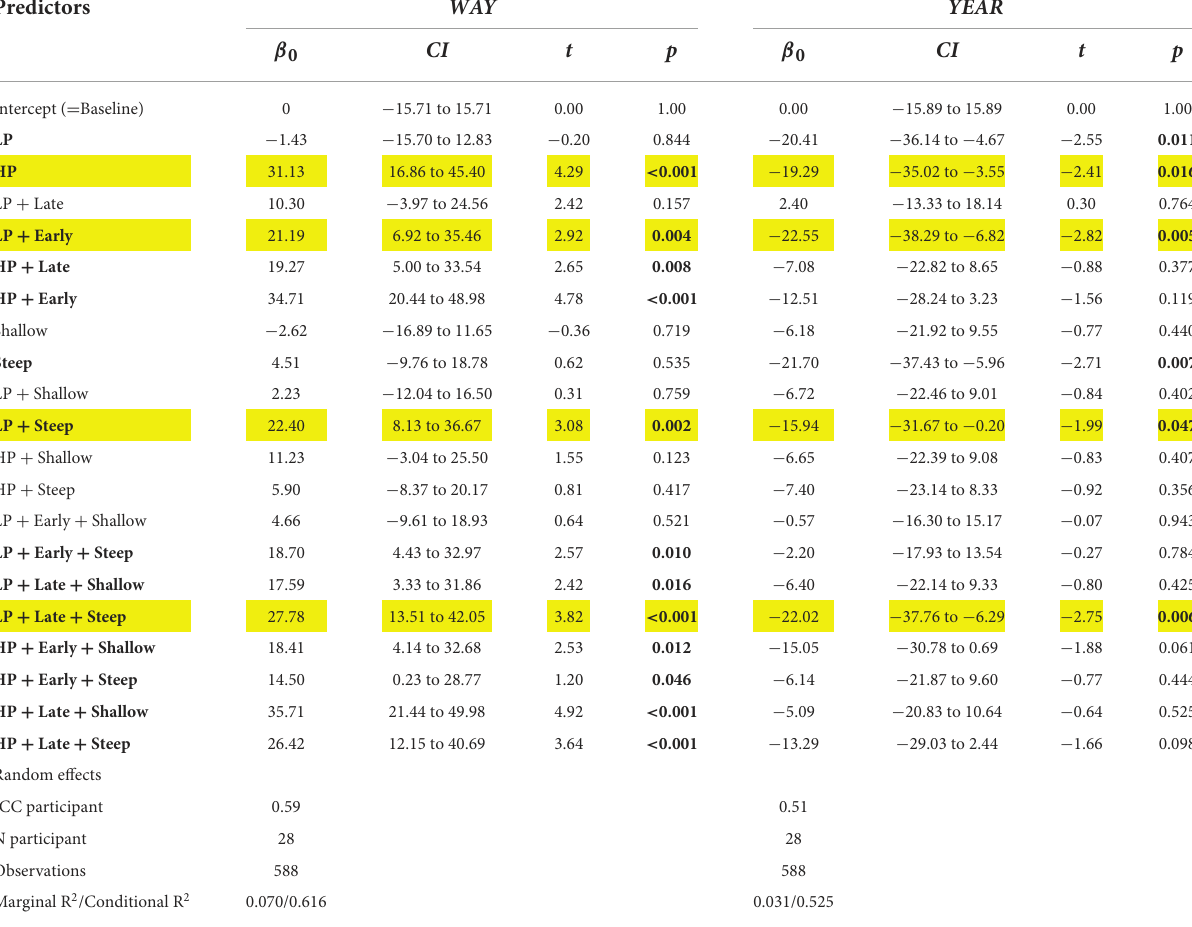
TABLE 5 Estimated coefficients, confidence intervals and t values for the mixed effect model with manipulation as a fixed factor fitted to the perceived prominence magnitude data (baseline-normalized) in Test 2.